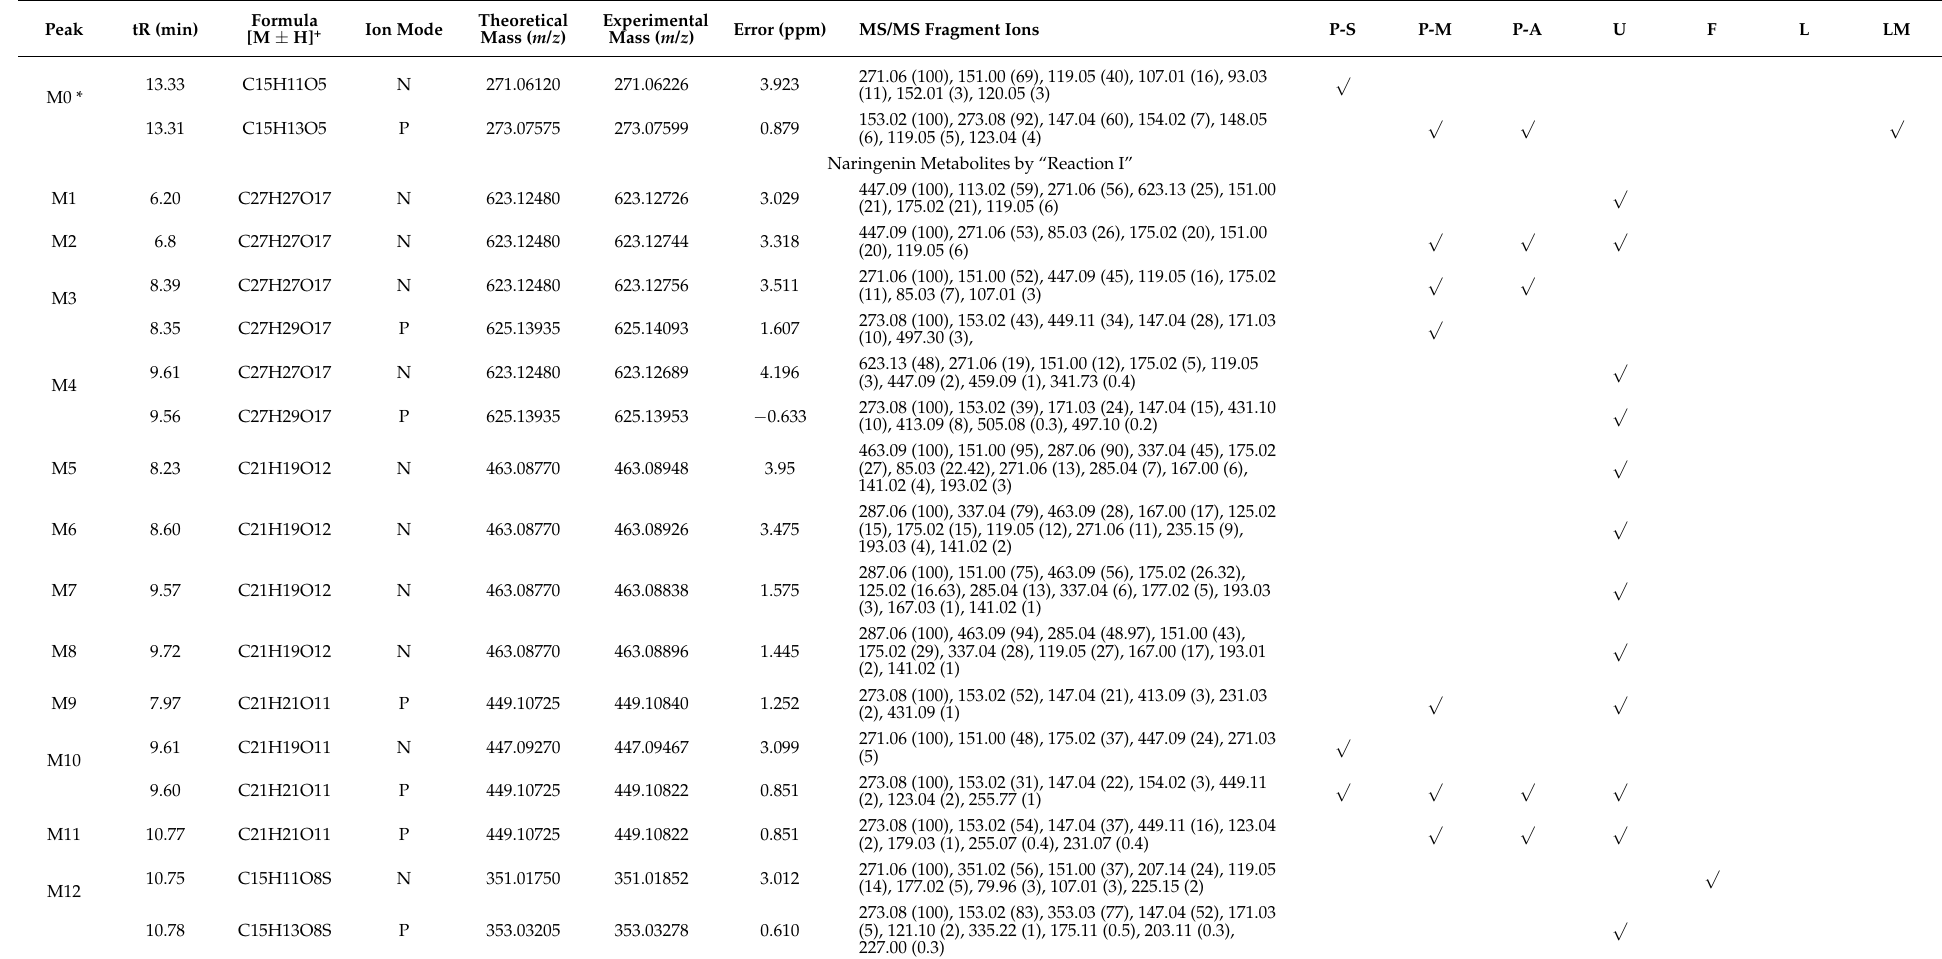
Table 1. Metabolites of naringenin in rat plasma, urine, feces, liver, and liver